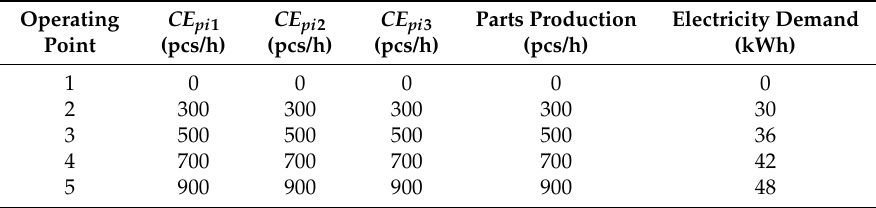
Table 3. Operating points of PPS#3, 4 and 5 during each time interval, i = 3, 4, 5.